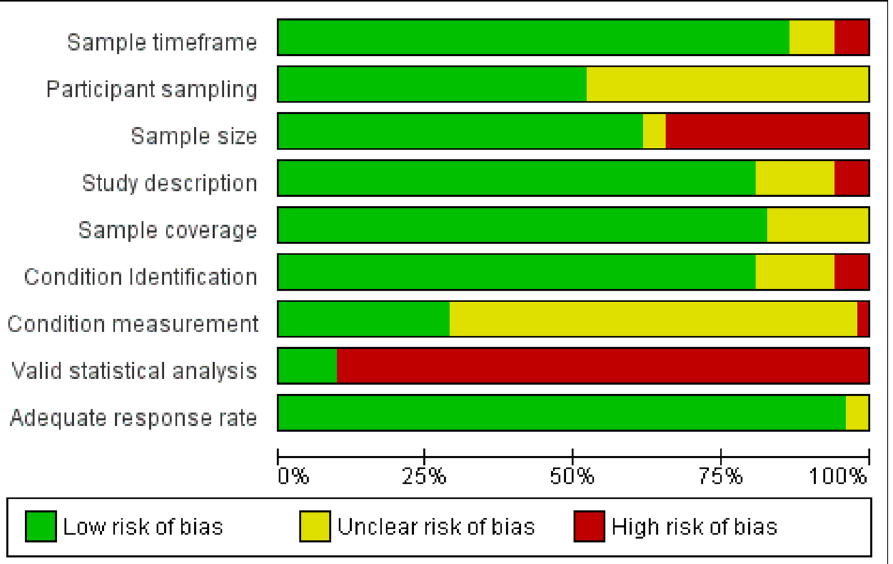
Figure 2. Risk of bias graph: review authors’ judgements about each methodological quality item presented as percentages across all included studies. Study number = 52.